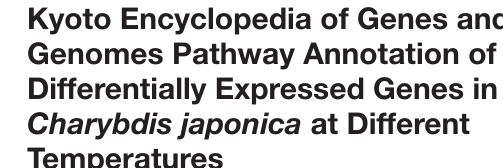
Table 3 . All unigenes were then compared with the sequences in protein databases to predict the gene function of C. japonica. A total of 20,121 unigenes were annotated in protein databases. Moreover, 8,503, 10,436, 13,494, 15,676, 11,742, 17,795, and 18,466 unigenes had remarkable matches with sequences in the GO, KEGG, KOG, Pfam, Swiss-Prot, eggNOG, and NR databases, respectively. Additionally, 12,125 CDSs and 12,854 SSRs were predicted in the unigenes. The number of mononucleotides, dinucleotides, trinucleotides, tetranucleotides, pentanucleotides, and hexanucleotides were 4,373, 4,468, 2,960, 179, 8, and 2, respectively.